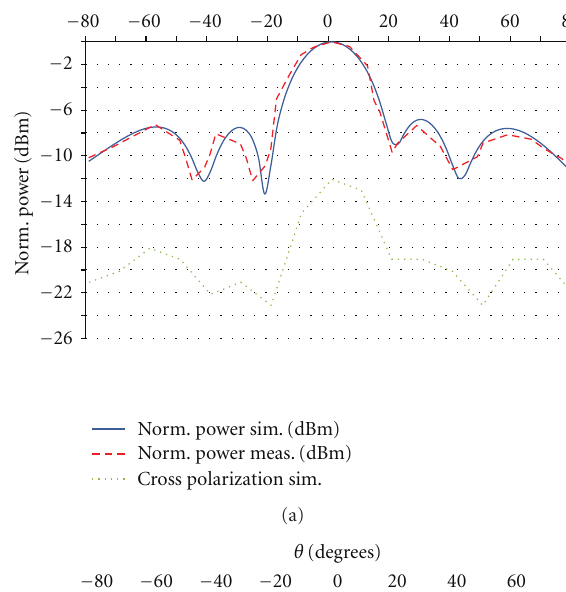
Figure 5: Backhaulantenna geometry and measurements.(a)Back- haul antenna model, (b) backhaul antenna prototype.